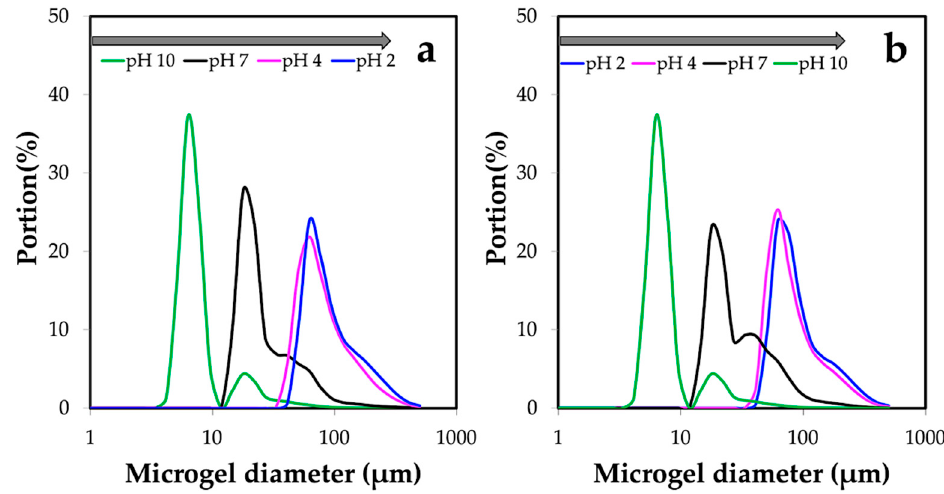
Figure 11. Reversible swelling-shrinking behavior of chitin microgels prepared under conditions of 3 % w / w chitin solution, O:W = 15:1, 5% w / w Span 80 (HLB 4.3), and gelation by using 800 µ L of 1.0 M HCl. Responsiveness to pH was tested from pH 10 towards pH 2 ( a ) and pH 2 towards pH 10 ( b ).